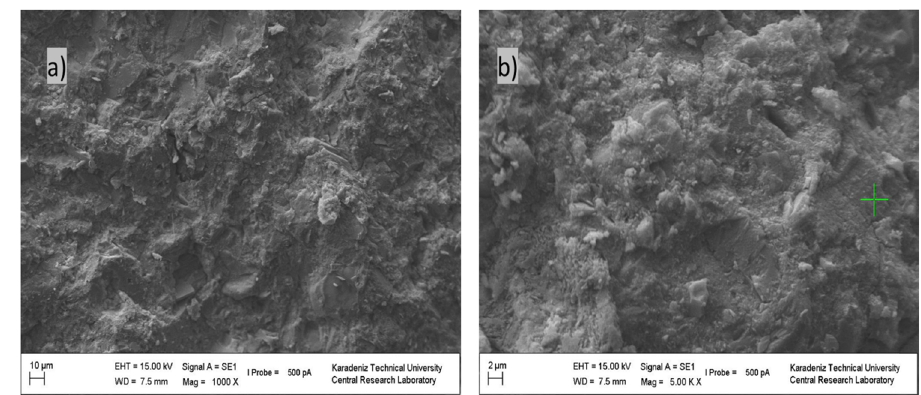
Figure 12: SEM images of 30% BVT ( a ) and 50% ( b ) BVT - blended cement paste samples at 28